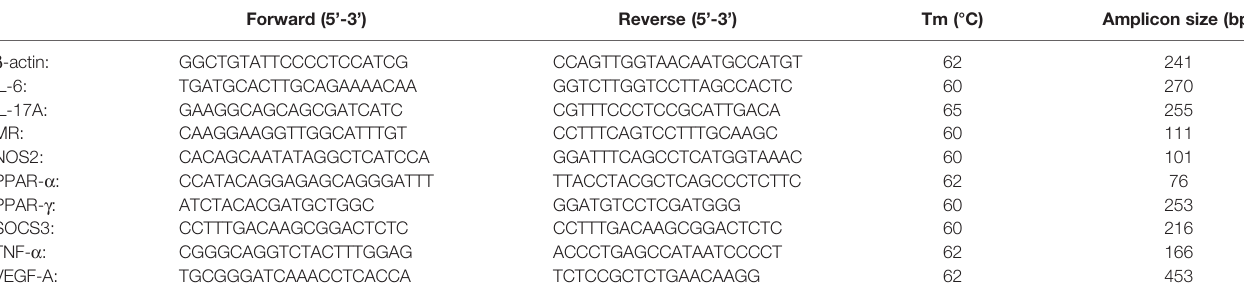
TABLE 1 | Primer sequences used for RT-qPCR, including melting temperature and amplicon size, were provided. Forward (5 ’ -3 ’